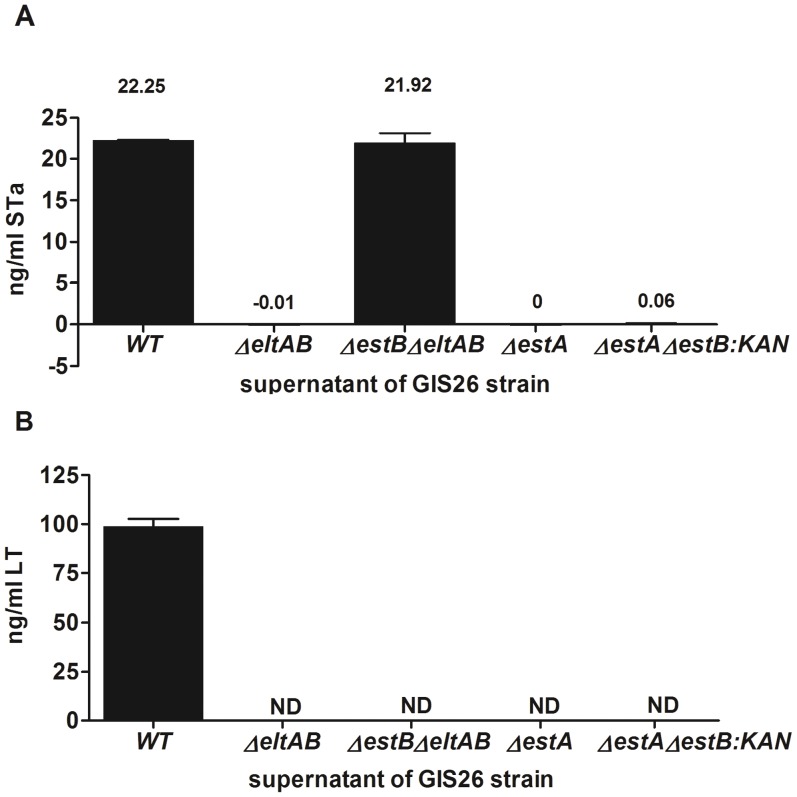
Quantitative detection of STa (A) and LT (B) expression by different isogenic ETEC strains following in vitro culture.Both toxins were detected by enzyme immunoassays. Mean values ± SD are shown. (A) Samples for STa were tested in triplicate in three independent experiments. (B) LT results are representative for 2 independent experiments. ND  =  below detection limit of 10 ng/ml. WT  =  wild type strain.